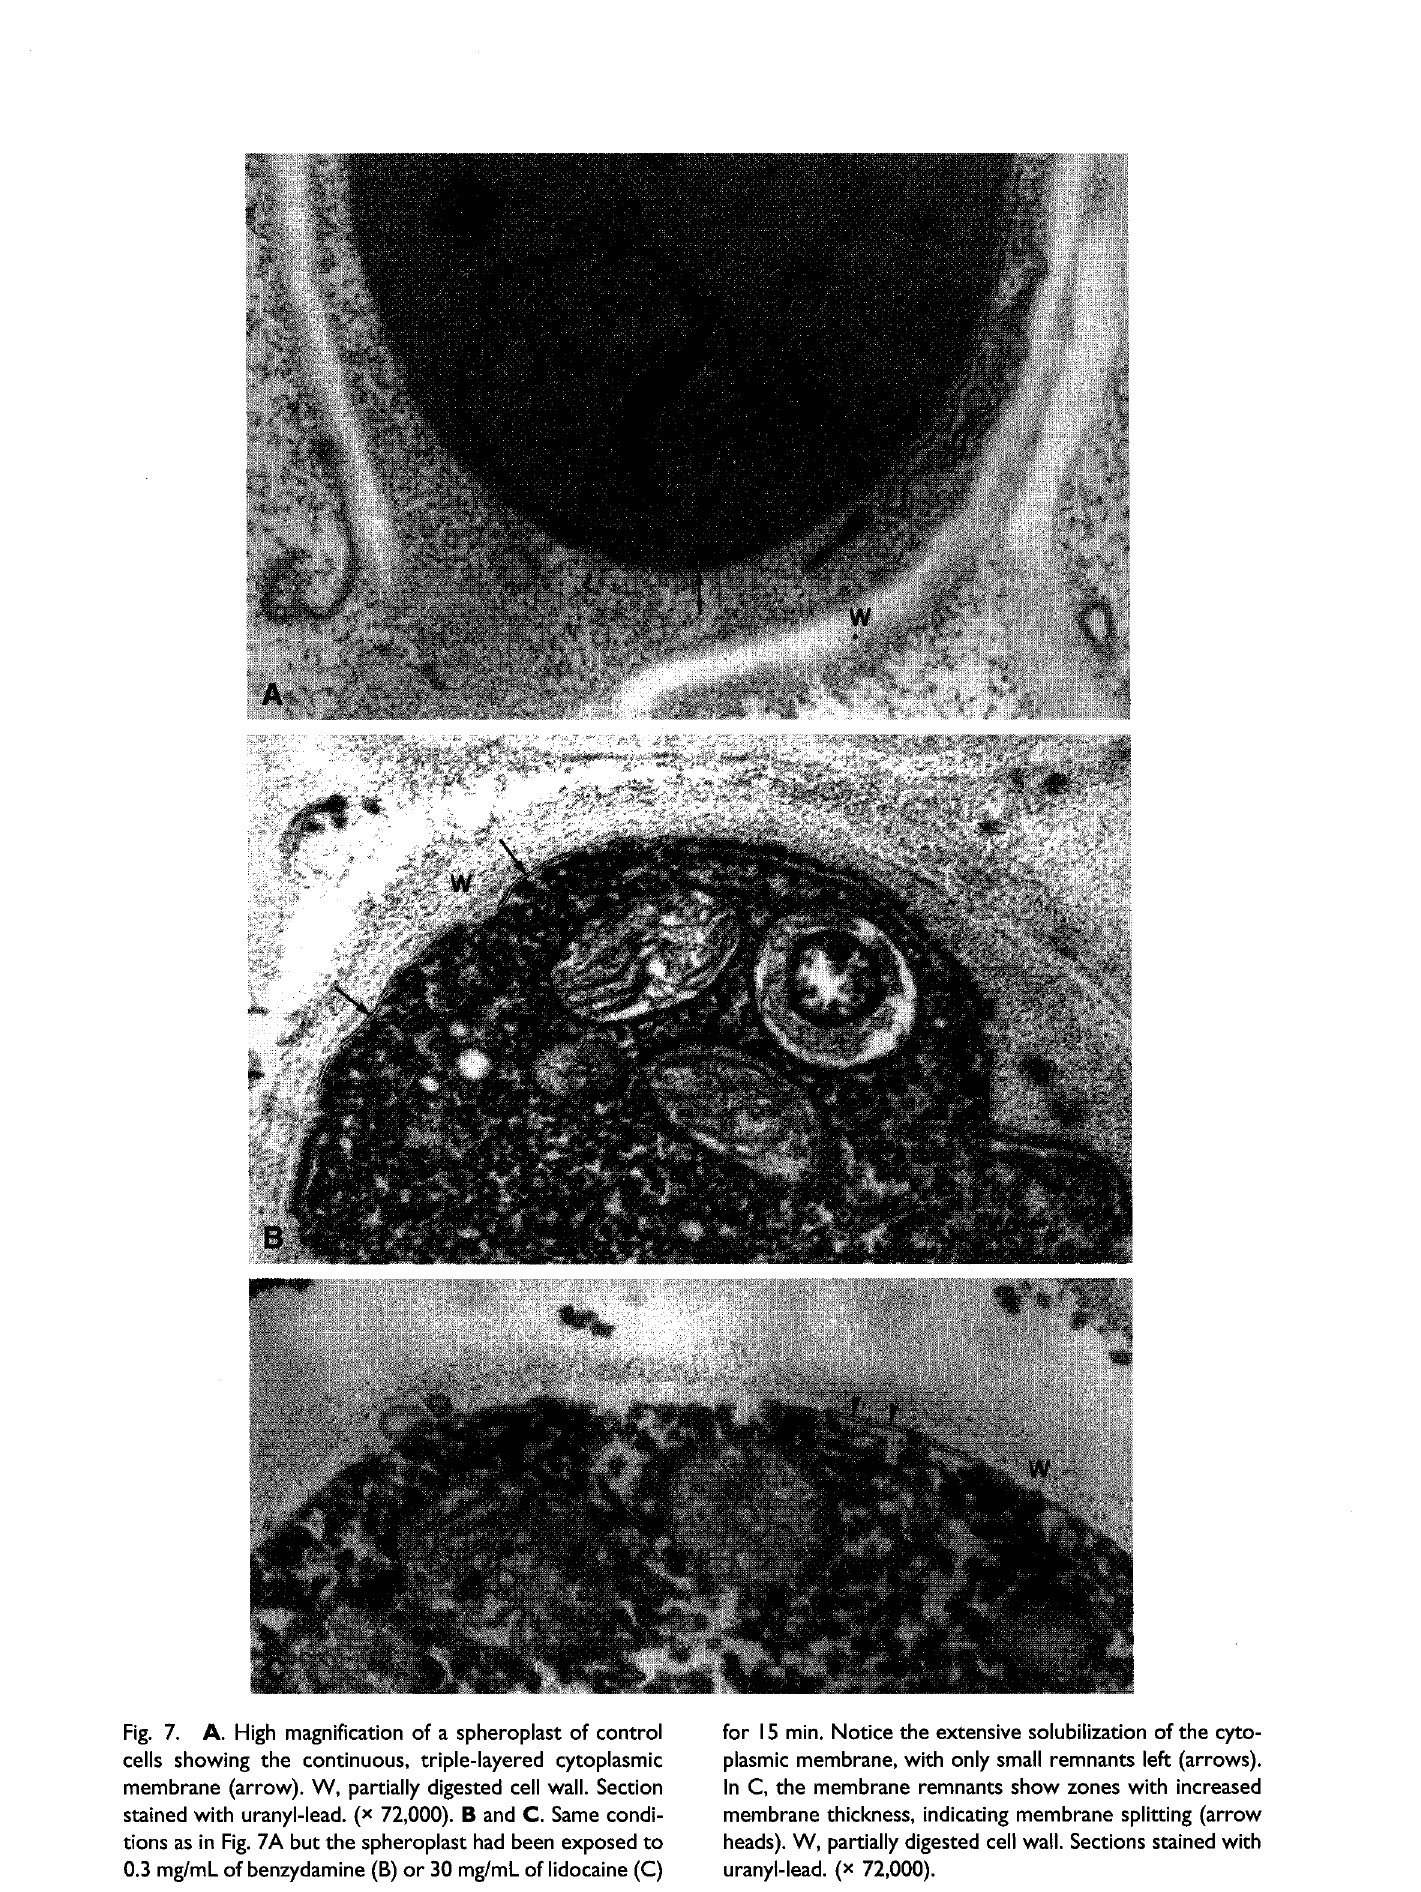
for 15 min. Notice the extensive solubilization of the cyto- plasmic membrane, with only small remnants left (arrows). In C, the membrane remnants show zones with increased membrane thickness, indicating membrane splitting (arrow heads). W, partially digested cell wall. Sections stained with uranyl-lead. (x